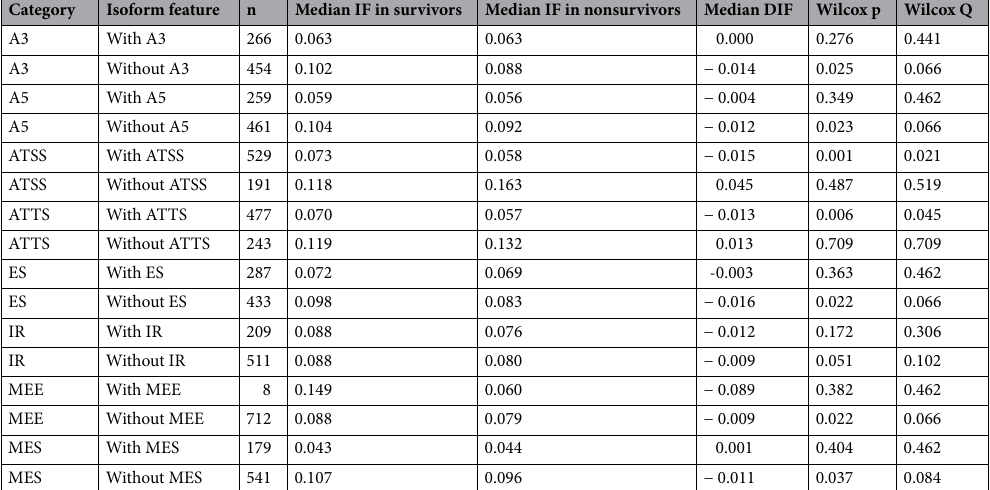
Table 3. Genome wide Analysis of alternative splicing. The significance test is performed using Mann– Whitney-U and resulting p-values are corrected using FDR (Benjamini-Hochberg). IF isoform fraction, AS alternative splicing, IR intron retention. A5 Alternative 5 ′ donor site (changes in the 5 ′ end of the upstream exon), A3 alternative 3 ′ acceptor site (changes in the 3 ′ end of the downstream exon), ATSS alternative transcription start site, ATTS alternative transcription termination site, ES exon skipping, MES multiple exon skipping, skipping of > 1 consecutive exons, MEE mutually exclusive